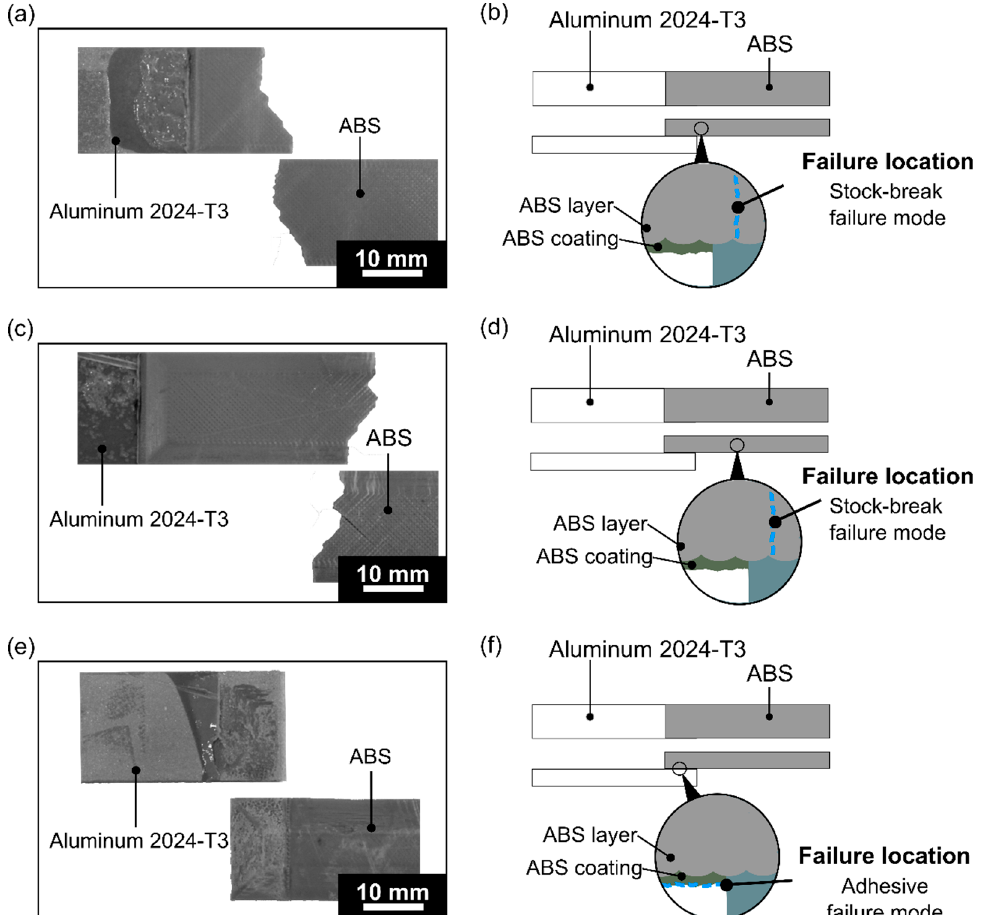
Figure 23. Aluminum 2024 ‐ T3/ABS hybrid joint failed joint under a quasi ‐ static lap shear test with its